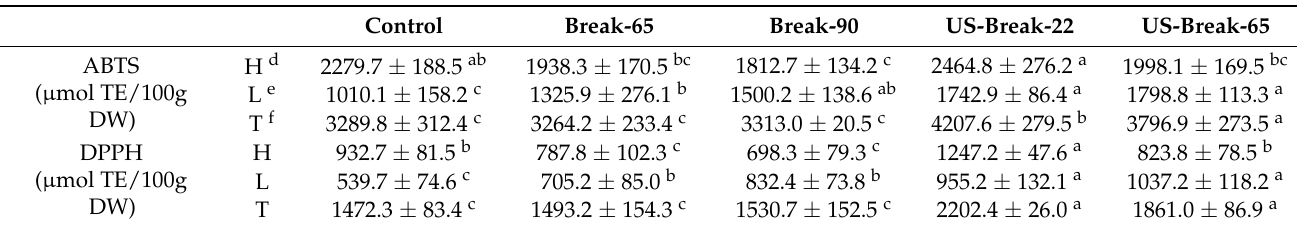
Table 4. Effects of different breaking treatments on the hydrophilic (HAA) and lipophilic (LAA) antioxidant activity of tomato pastes evaluated by DPPH and ABTS analysis.